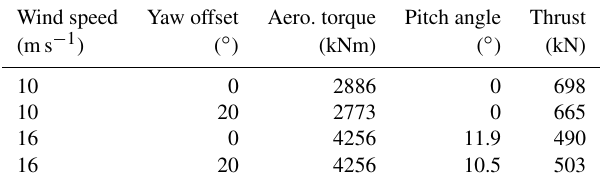
Table 3. Mean values of key operational variables for the 5MW NREL turbine during steady operation at specified values of mean wind speed and yaw